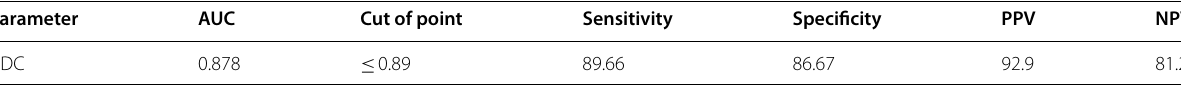
Table 2 ADC: accuracy, sensitivity, specificity, PPV and NPV Parameter AUC Cut of point Sensitivity Specificity ADC